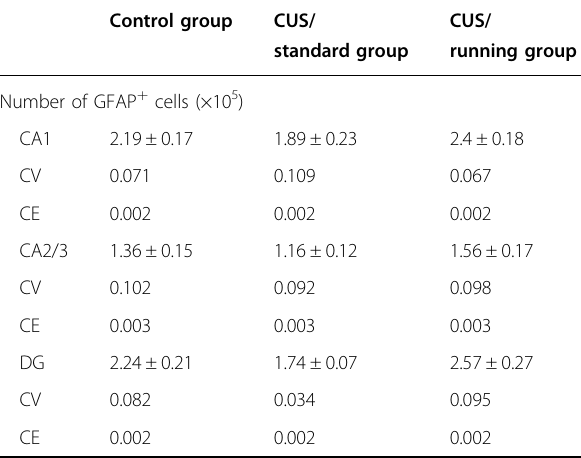
Table 4 The number of GFAP + cell numbers. Control